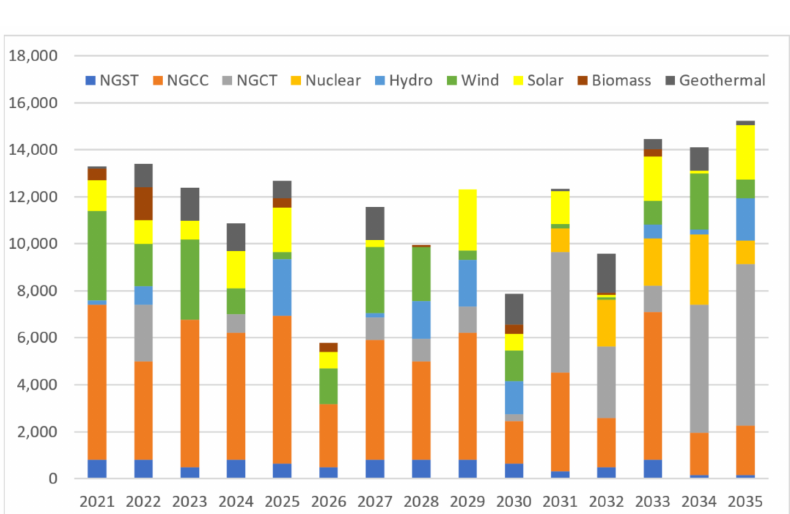
Figure 4. The capacity of additional units in each kind of power plant by the year in scenario 2